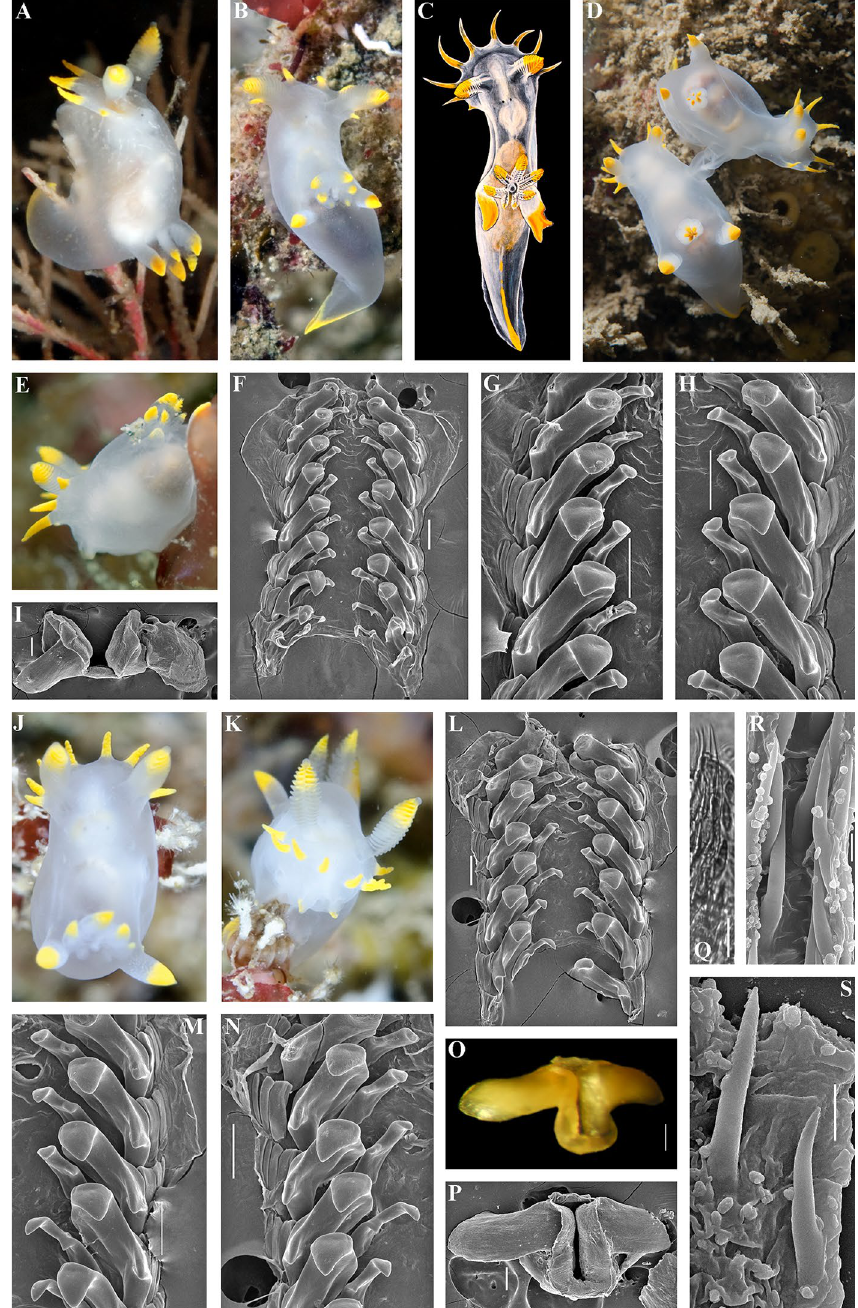
Figure 9. Polycera kernowensis sp. nov. External and internal morphology, light and scanning electron microscopy and comparison with data from Thompson and Brown 40 . ( A ) Paratype from United Kingdom, Cornwall, Porthkerris, dorsal view, live (FD 01). ( B ) Paratype from United Kingdom, Cornwall, Porthkerris, dorsal view, live (FD 093). ( C ) Specimen from United Kingdom, Skomer Island, depicted in Thompson and Brown ( 40 : pl 18, e) identified as P. faeroensis but which has some features that more similar to P. kernowensis sp. nov. ( D ) Copulating specimens from the Great Britain, dorsal view, live. ( E ) Paratype from Portugal, Setubal, lateral view, live (ZMMU Op-775). ( F ) Radula, SEM (ZMMU Op-775). ( G , H ) Radula details, SEM